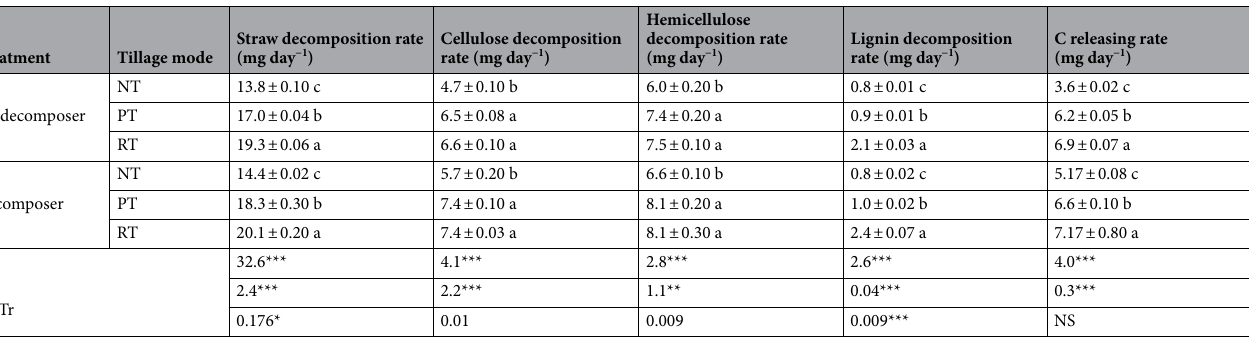
Table 2. Straw decomposition and carbon release rates under different return modes. F: Methods of returning farmland; Tr: processing. Different letters after the mean indicate a significant difference between treatments. *, ** and *** indicate a significance difference at 0.05, 0.01 and 0.001 levels, respectively. NS no significant difference.